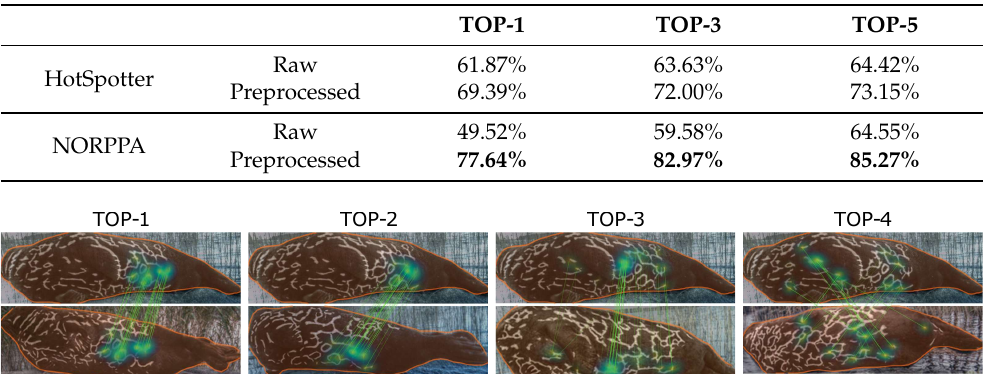
Figure 8. TOP-4 examples for the NORPPA algorithm. First line: query image (phs10), Second line: four best matches in decreasing order of similarity from left to right. Matched hotspots are highlighted in green. TOP-1–TOP-3 matches are correct. TOP-4 is incorrect.